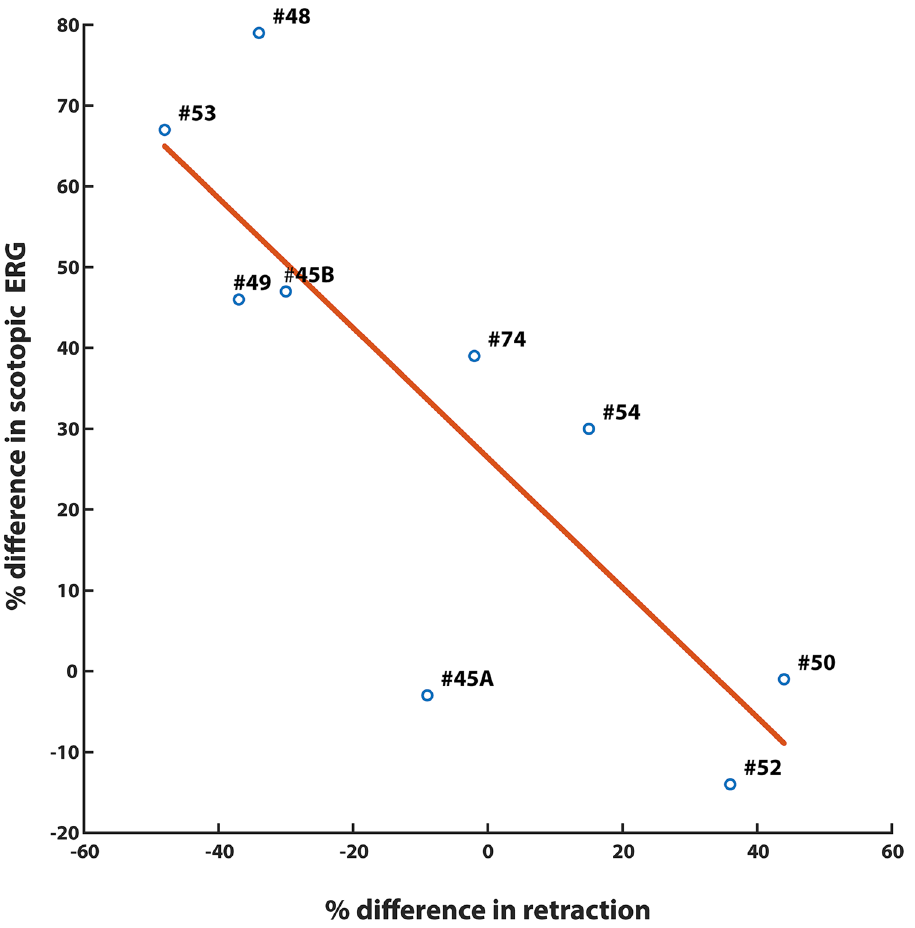
Figure 6. Correlation between the morphological and functional outcomes 2 days after injury. Linear regression model was applied to n = 9 animals. The dose of the drug (0.5 μM, n = 6 animals, and 25 μM, n = 3 animals) and the size of the retinal bleb (quarter-, n = 8 animals, or half of the retina, n = 1 animal) varied among these animals; a correlation between the anatomical and the functional change is present. (#numbers are identification numbers for individual animals, see Suppl. Table